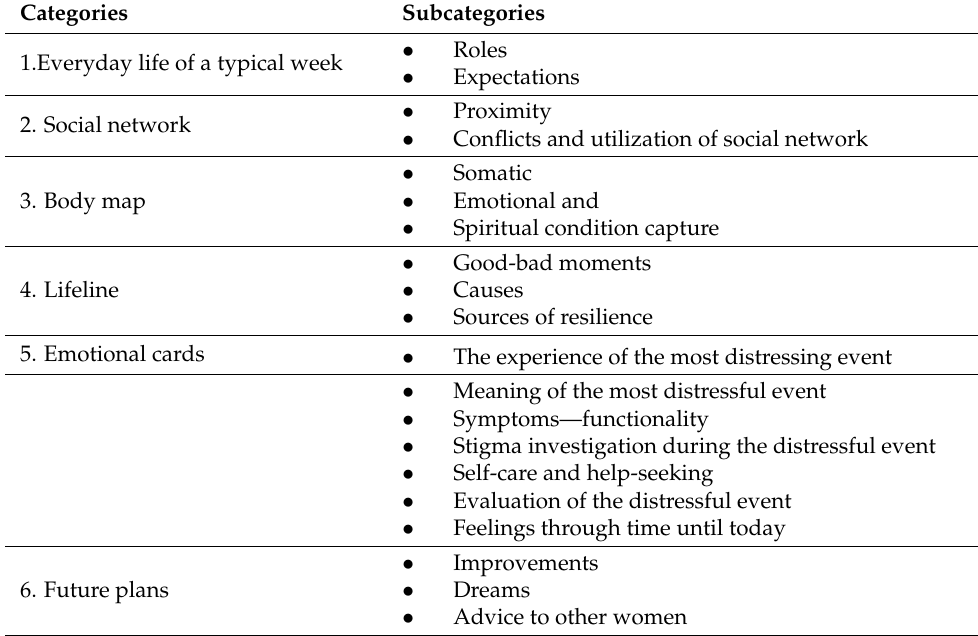
Table 2. Main themes and categories of the